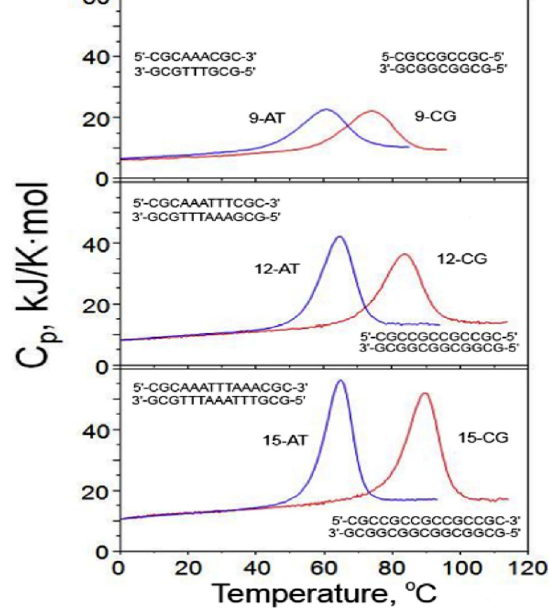
Figure 4. Partial molar heat capacities of 9, 12, and 15 base-pair CG duplexes (red) and the same-length duplexes, including AT pairs (blue) [11,12,15].